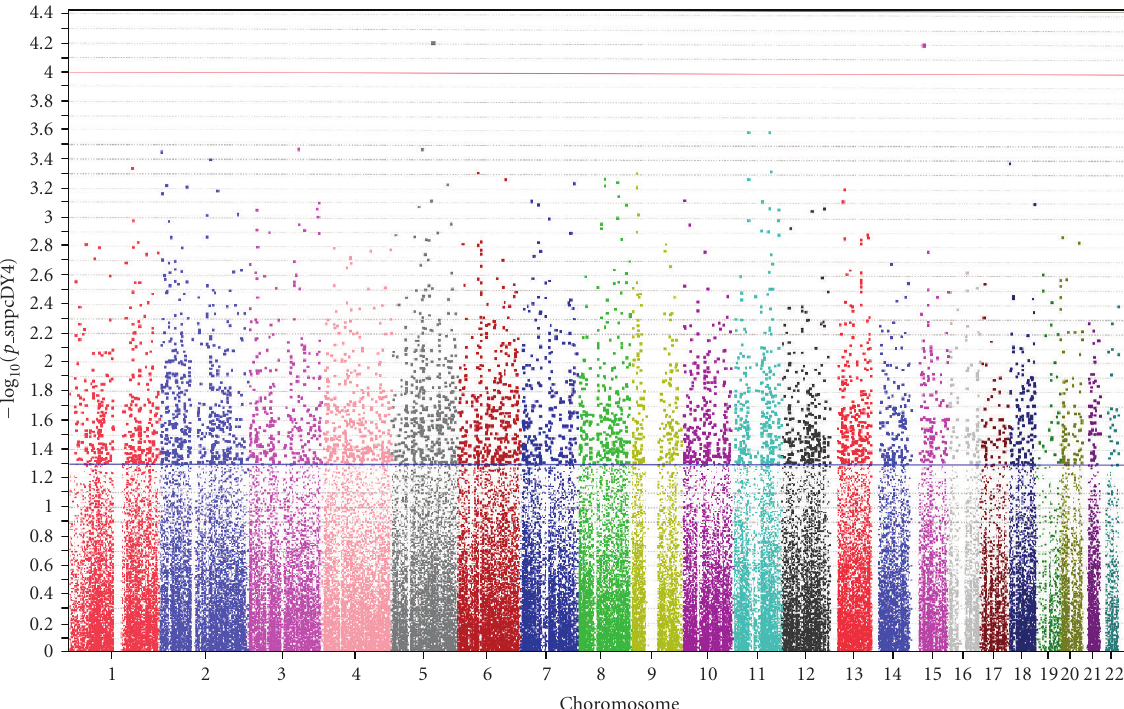
Figure 1: Summary of genome-wide associations between 111,528 SNPs and severe diabetic retinopathy under additive genetic model adjusted for age, gender, diabetes duration, and HbA1c level.